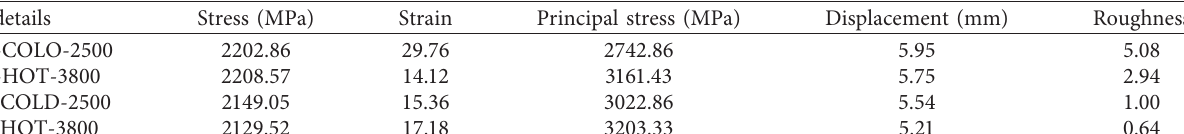
Figure 10: Correspondence of surface roughness with (a) feed rate and (b) rotational speed. Table 8: Comparative average values of simulation outcomes and surface roughness.